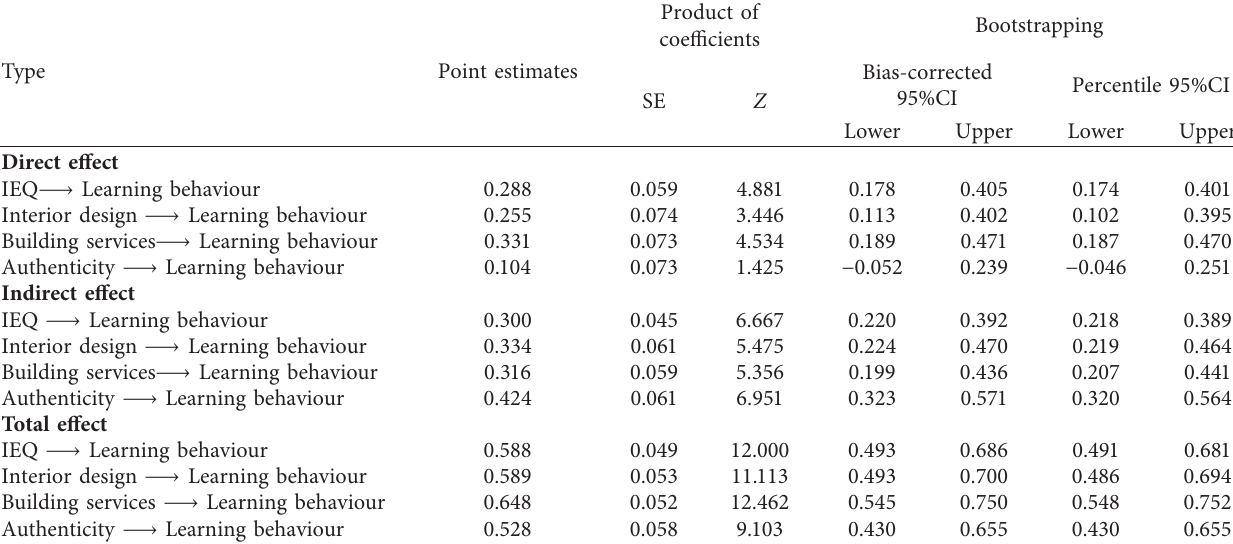
Table 9: Mediator effect analysis.